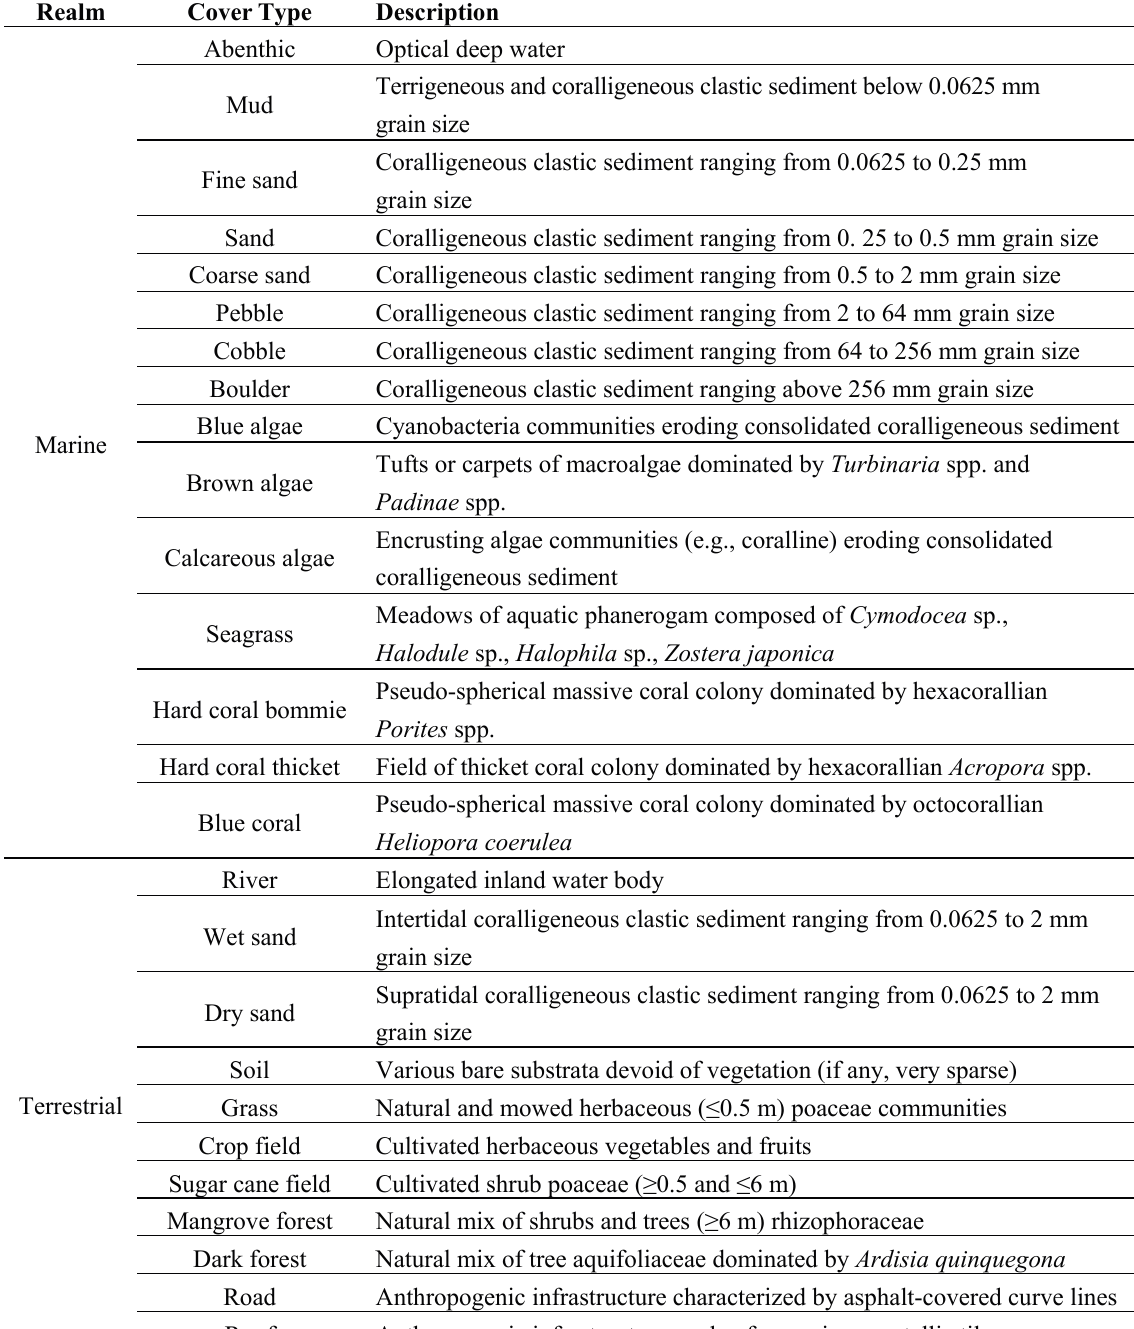
Table 1. Description of the 26 seamless coastal cover types in Shiraho, which contain 15 marine and 11 terrestrial